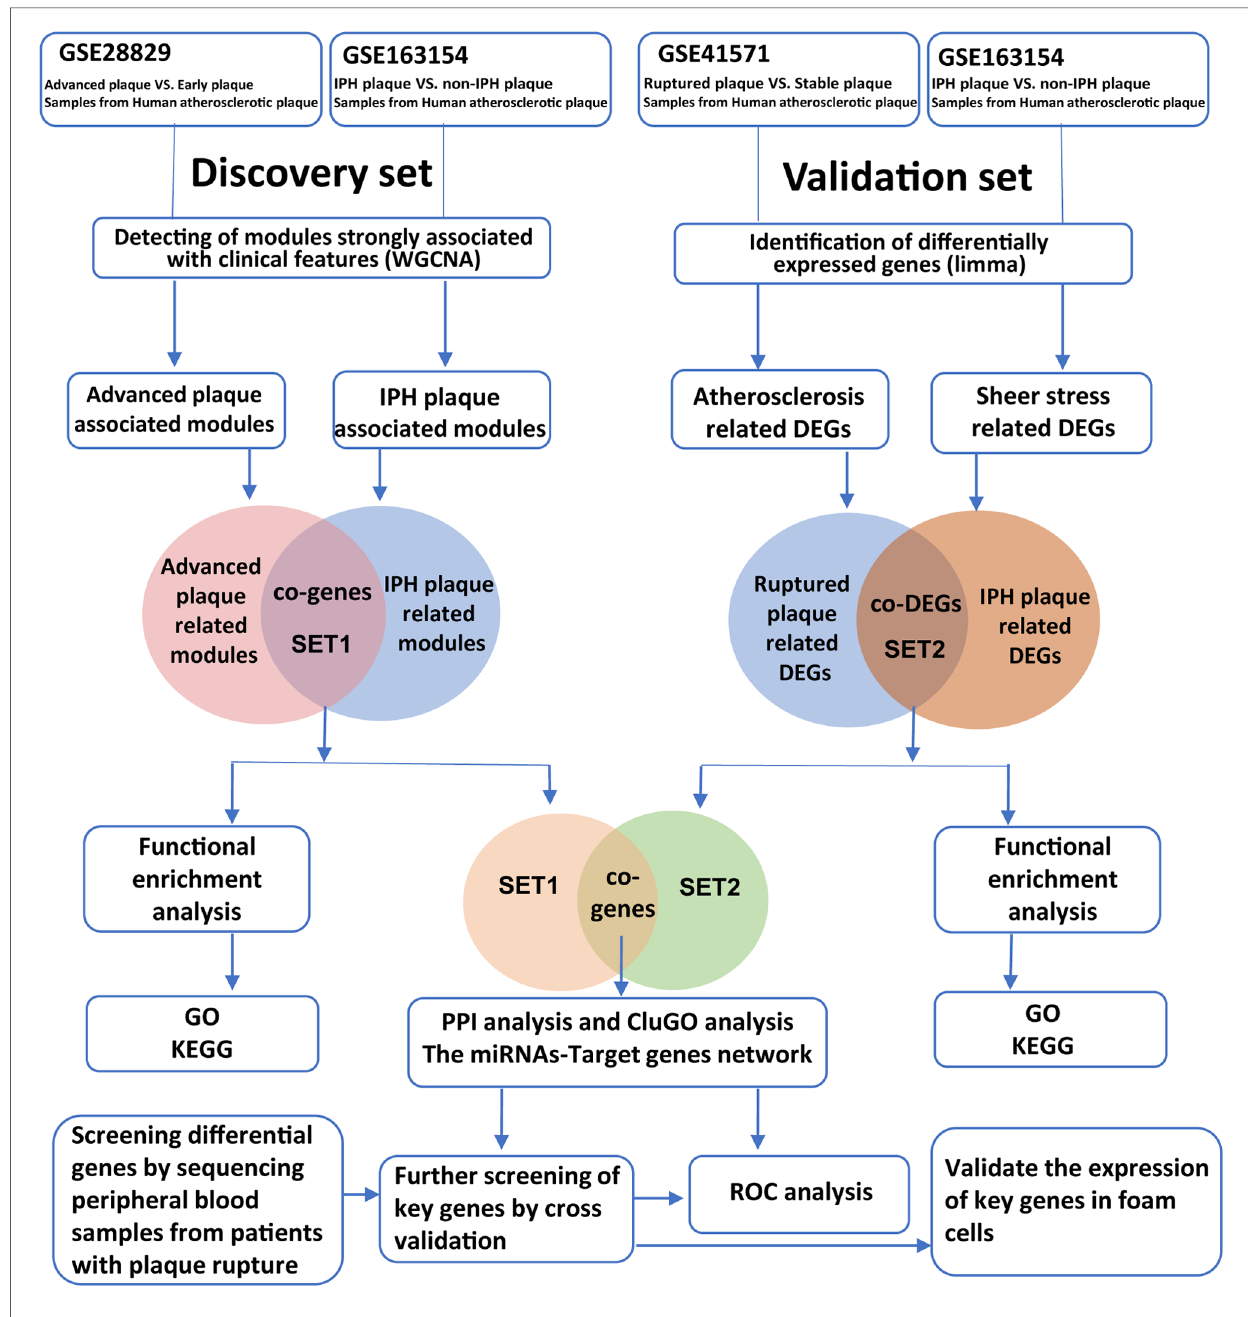
FIGURE 1 Work fl ow of bioinformatics